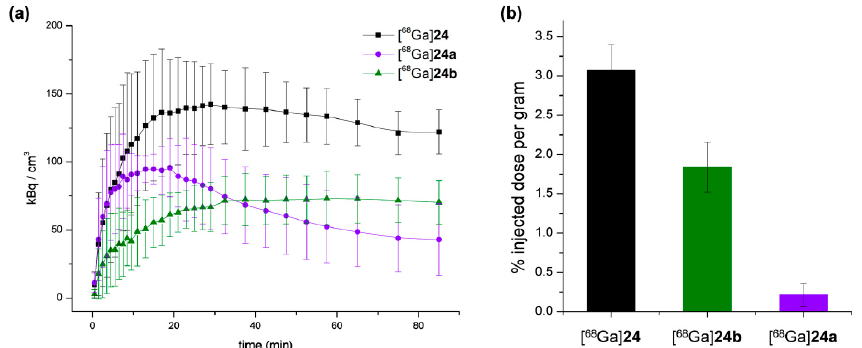
Figure 9. Absolute tumor uptakes as determined by in vivo PET imaging as well as ex vivo biodistribution experiments ( n = 4). ( a ) Time-activity-curves are depicted, showing tumor uptakes over the course of PET imaging for [ 68 Ga] 24 (black), [ 68 Ga] 24a (purple) and [ 68 Ga] 24b (green); ( b ) Tumor uptakes (% injected dose per gram) are shown for [ 68 Ga] 24 (black), [ 68 Ga] 24a (purple) and [ 68 Ga] 24b (green) as determined by ex vivo biodistribution directly after the completed diagnostic